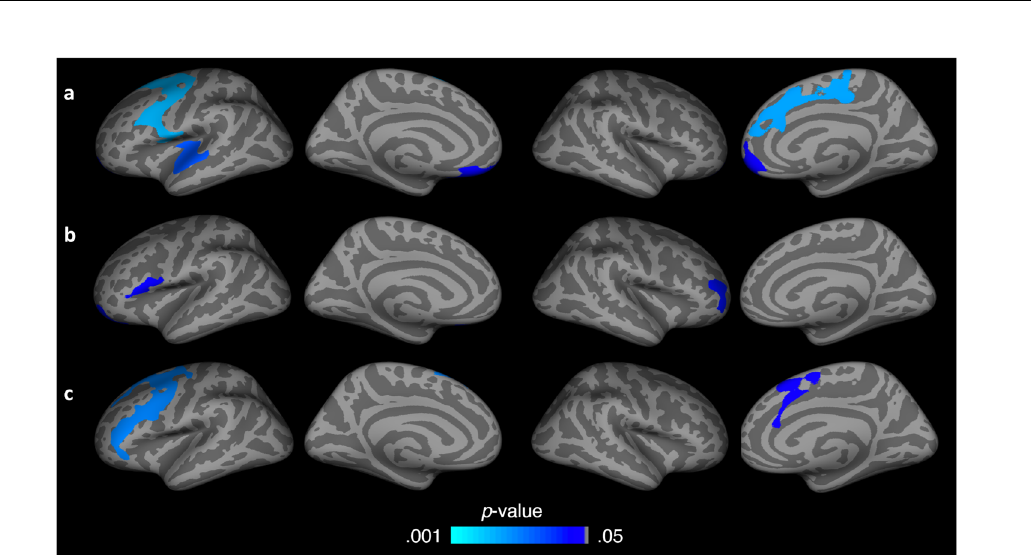
Fig. 2 | Longitudinal differences in cortical gray matter between groups. Cor- rected signi fi cance map showing cortical areas that exhibited a signi fi cant inter- action of group by time in vertex-wise repeated measures ANOVAsthat controlled for age and total brain volume in analyses of volume ( a ) and surface area ( b ), and that controlled for age in analyses of the thickness ( c ). Signi fi cance maps were